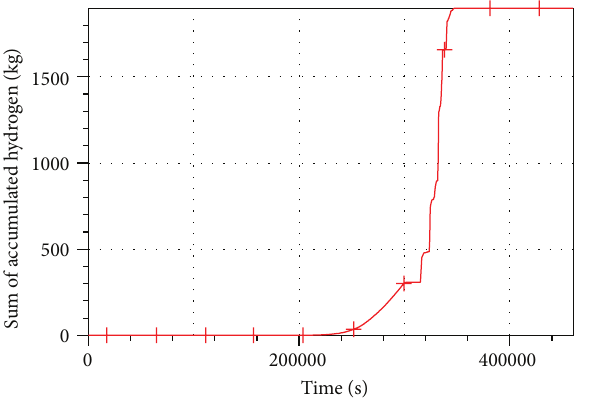
Figure 8: Hydrogen generation.